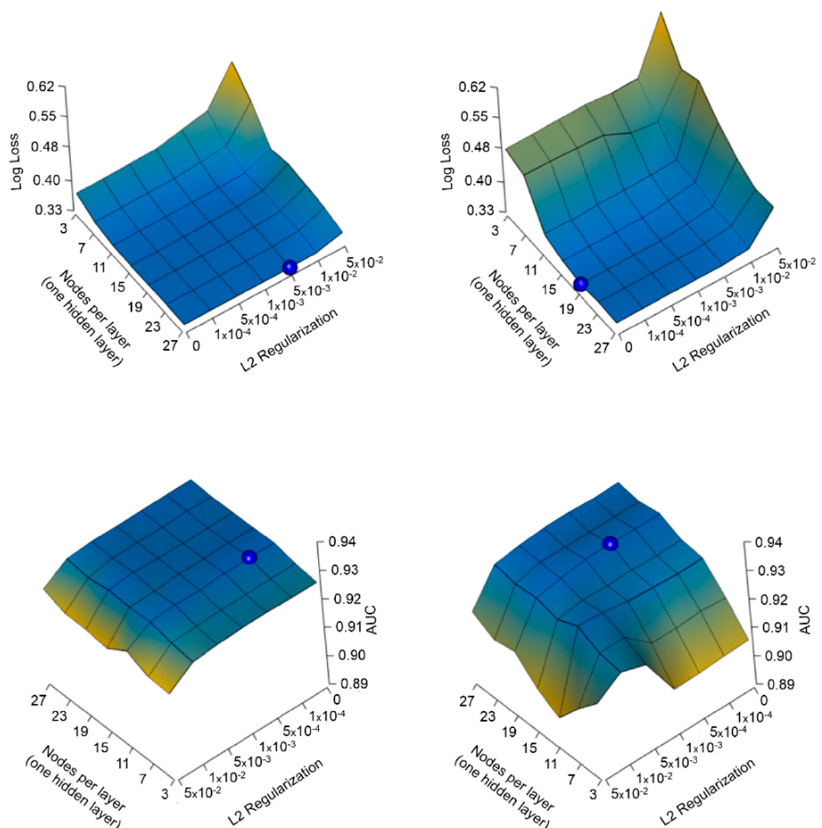
Figure 3. Performance of the sex classification on the validation dataset during parameter tuning. The top graphs show the performance as log loss, while the bottom ones use the area under the receiver operating characteristic (ROC) curve (area under curve or AUC). The performance is compared across different values of the tuned parameters: L2 regularisation, number of nodes per layer, and number of hidden layers (the results for models trained with one hidden layer are shown on the left, with two hidden layers on the right). The performance improves from yellow to blue, specifically with log loss decreasing and AUC increasing. The blue sphere indicates the best performing model: it shows the maximum performance obtained and the relative values of the tuned parameters that produce that performance.